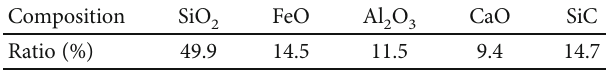
Table 1: Composition ratio of particles in the experiment.